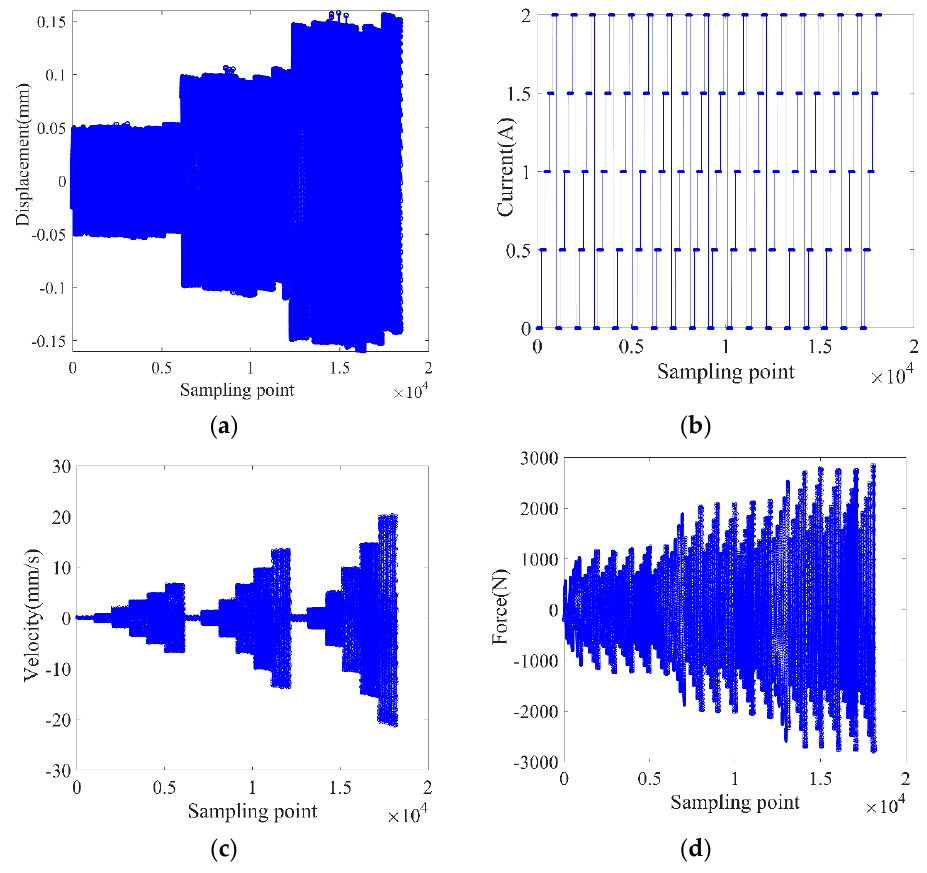
Figure 6. Training data: ( a ) displacement, ( b ) velocity, ( c) current, ( d ) force.